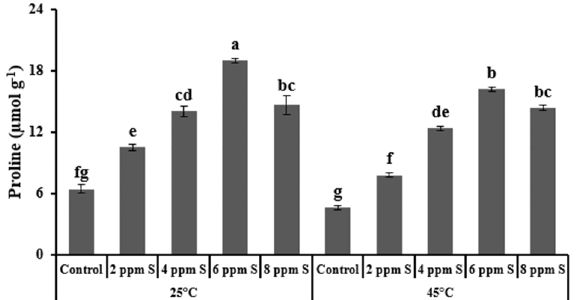
Figure 7. Proline contents of tomato plants (cv. Ahmar) as affected by temperature, genotype, and exogenous application of sulfur. Same letters indicate non-significant differences among treatments according to Tukey’s honestly significant difference test ( p ≤ 0.05). Vertical bars indicate averages ± standard errors ( n = 4, 5 plants per replicate).